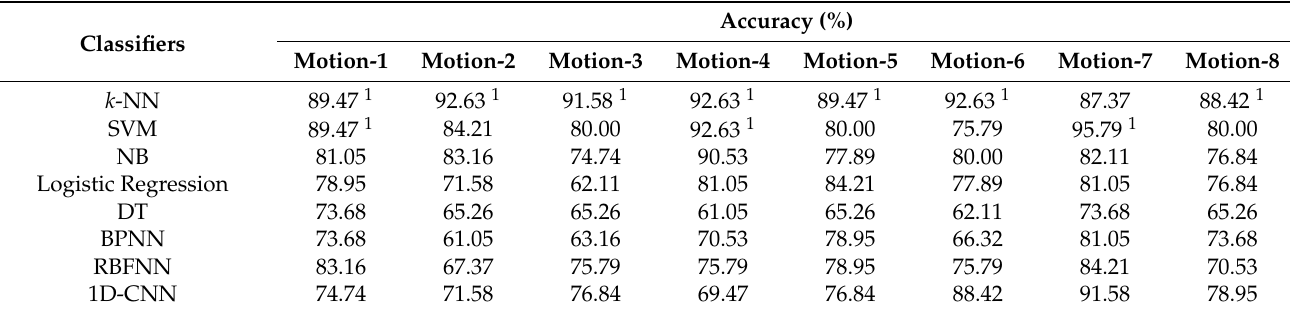
Table 3. Accuracy of motion assessment of different classifiers, using scores from Teacher A.